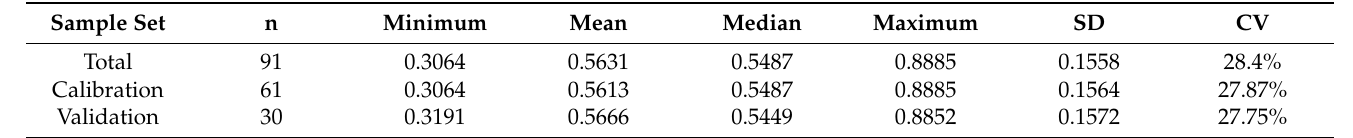
Table 1. Descriptive statistics of total content (TN, g/kg) in the entire